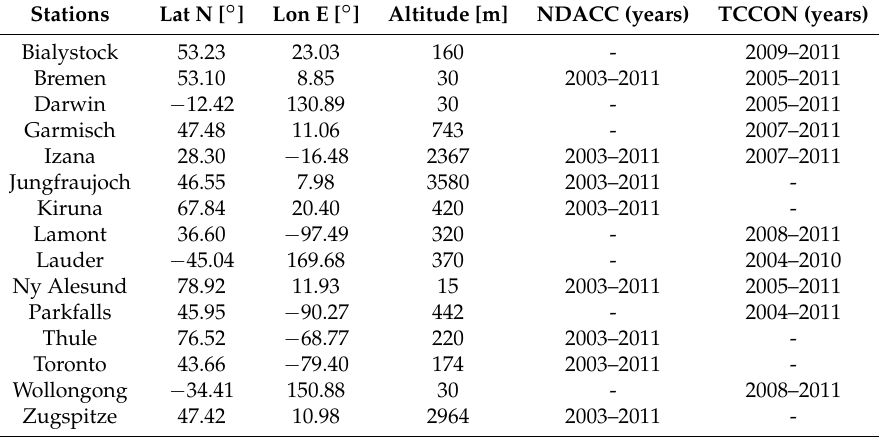
Figure 1. World map created by Feist [16] showing stations affiliated to ground-based (g-b) observing networks routinely measuring trace gases such as CO in the mid-infrared (MIR) and short-wave infrared (SWIR) ranges. The background color scheme also provides some information on the ground reflectance in the SWIR range (e.g., the variations of the reflectance on the continents and also the difference between land and the oceans). Table 1. The Network for the Detection of Atmospheric Composition Change (NDACC) and Total Carbon Column Observing Network (TCCON) g-b Fourier transform infrared (FTIR) stations used in this validation. The last two columns indicate the time span of the g-b data used for the comparison to the Scanning Imaging Absorption Spectrometer for Atmospheric Chartography (SCIAMACHY). Further details see Appendix A and